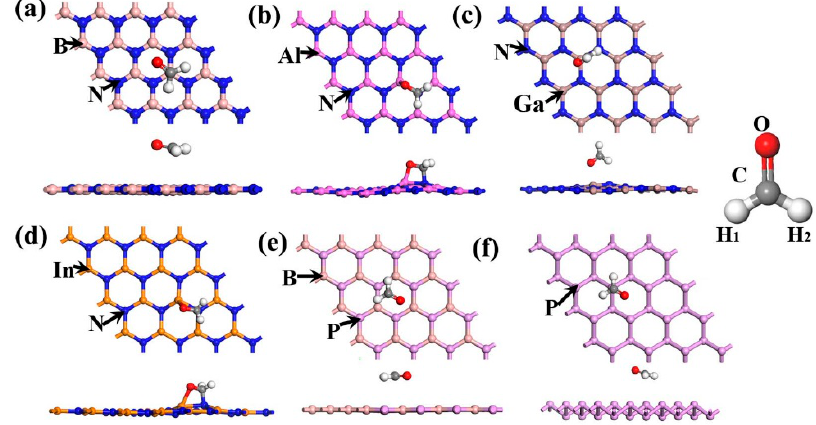
Figure 2. Most stable adsorption structures of CH 2 O on the surface of the ( a ) BN, ( b ) AlN, ( c ) GaN, ( d ) InN, ( e ) BP, and ( f ) P monolayers.